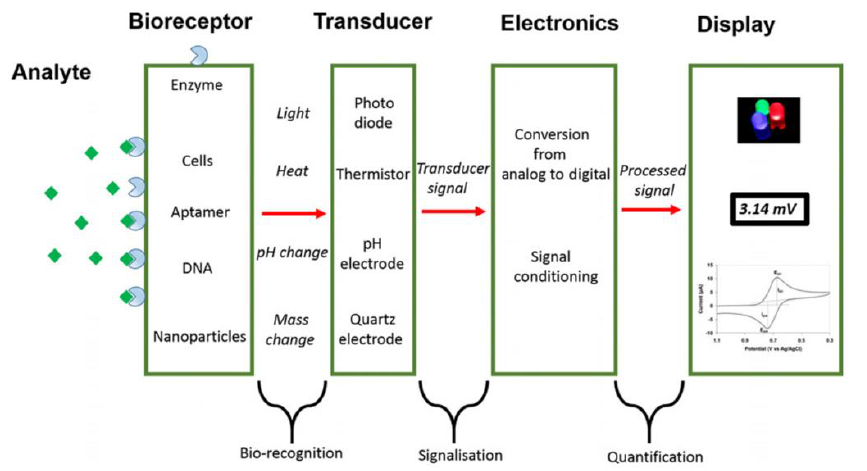
Figure 2. Schematic representation of a biosensor. Reproduced with permission from Bhalla et al. [14], Essay in Biochemistry, 60, 1–8. Published by Portland Press,